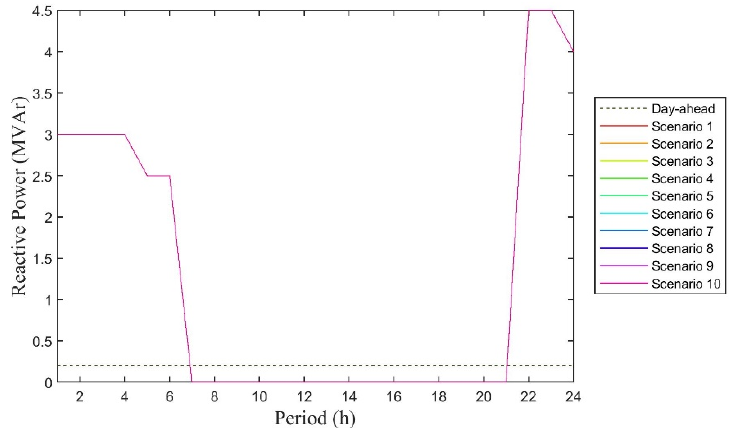
Figure 6. Reactive power production of capacitor bank 1 throughout 24 hours.